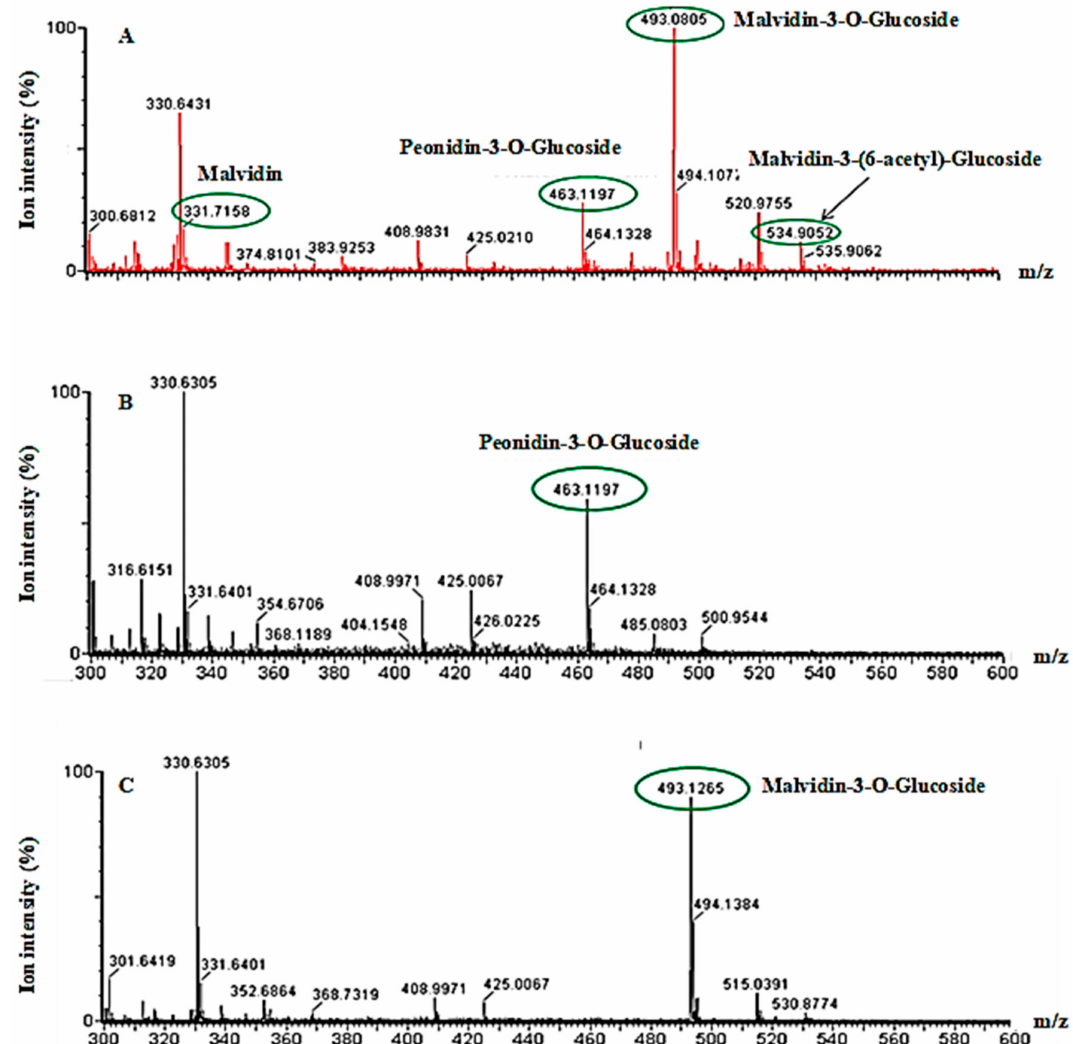
Figure 2. MALDI-TOF MS analysis. ( A ) Raw extract spectrum, confirming the presence of several anthocyanins, including malvidin, malvidin-3- O -glucoside, peodinin-3- O -glucoside, and malvidin-3-(6-acetyl)-glucoside. ( B ) Fraction 1 and ( C ) Fraction 2 spectra, confirming the presence of peodinin-3- O -glucoside and malvidin-3- O -glucoside,